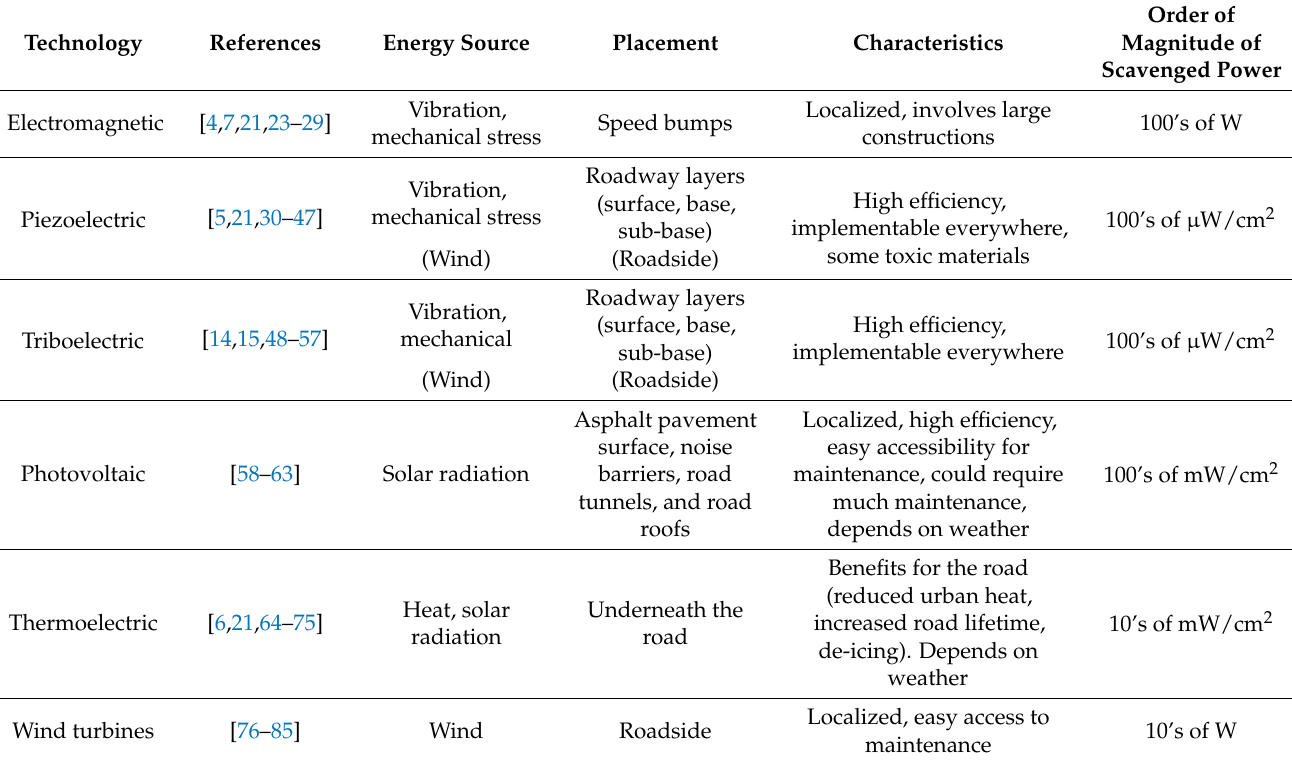
Table 1. Comparison between different technologies for energy harvesting from roads.